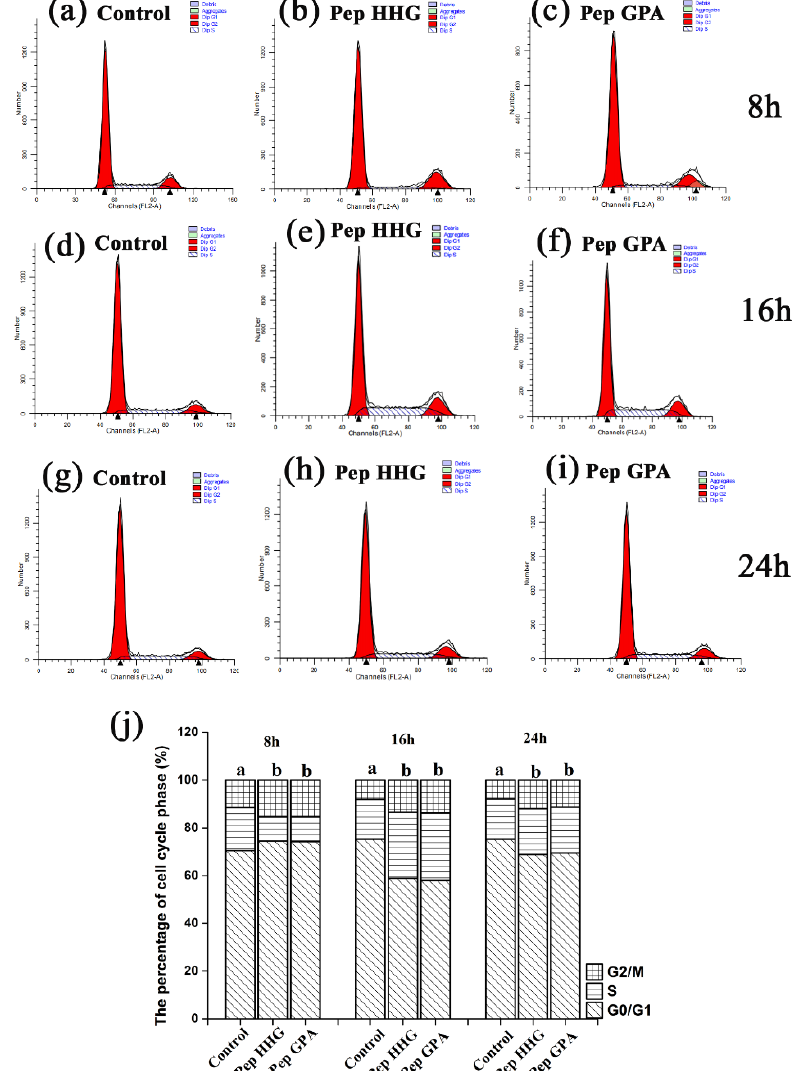
Figure 3. The cell cycle distribution of MC3T3-E1 osteoblasts cells after treatment with Pep HHG and Pep GPA and cultured for varying time periods assessed using flow cytometry ( a–i ). Cell cycle distribution of MC3T3-E1 osteoblasts in G0/G1, S, or G2/M phases ( j ). The different letters represent significant difference between groups, p < 0.05. ( a – c ) Control MC3T3-E1 osteoblasts and MC3T3-E1 osteoblasts treated with Pep HHG and Pep GPA for 8 h, respectively. ( d – f ) Control MC3T3-E1 osteoblasts and MC3T3-E1 osteoblasts treated with Pep HHG and Pep GPA for 16 h, respectively. ( g – i ) Control MC3T3-E1 osteoblasts and MC3T3-E1 osteoblasts treated with Pep HHG and Pep GPA for 24 h, respectively. Pep HHG: peptide HHGDQGAPGAVGPAGPRGPAGPSGPAGKDGR (Deamidation); Pep GPA: peptide GPAGANGDRGEAGPAGPAGPAGPR (Deamidation).